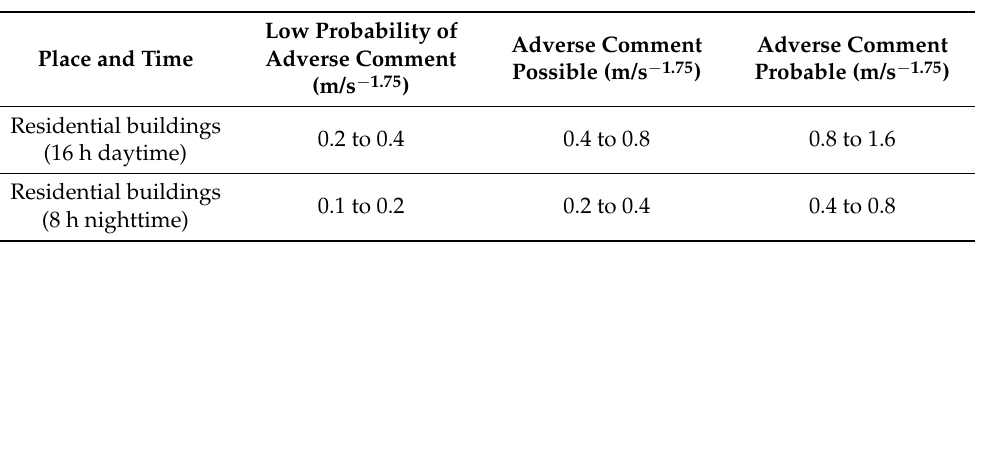
Table 7. The ranges of the VDV values presented in BS 6472-1 [29].